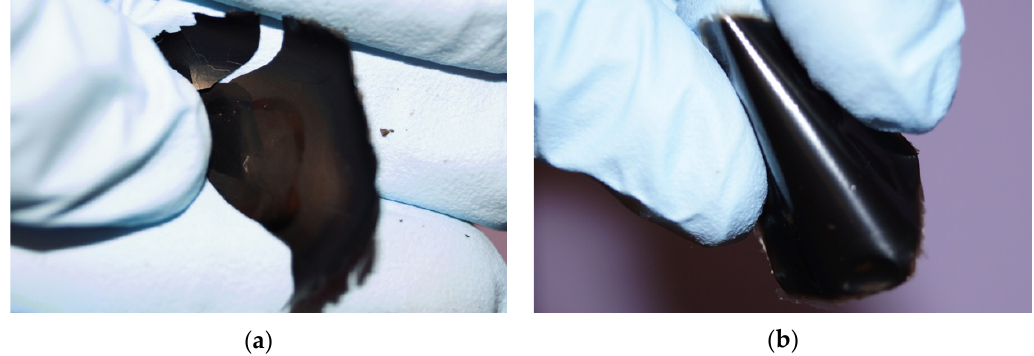
Figure 2. Cross-linked PPy–Alg films prepared from composite A ( a ) without and ( b ) with NaCO 3 .